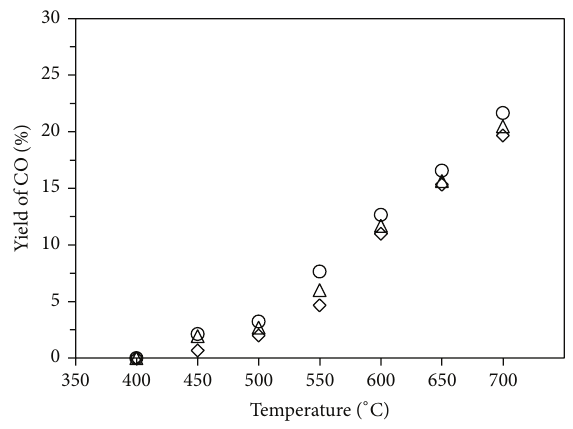
= 𝑃 = 1 kPa, balance H 2 CO 2